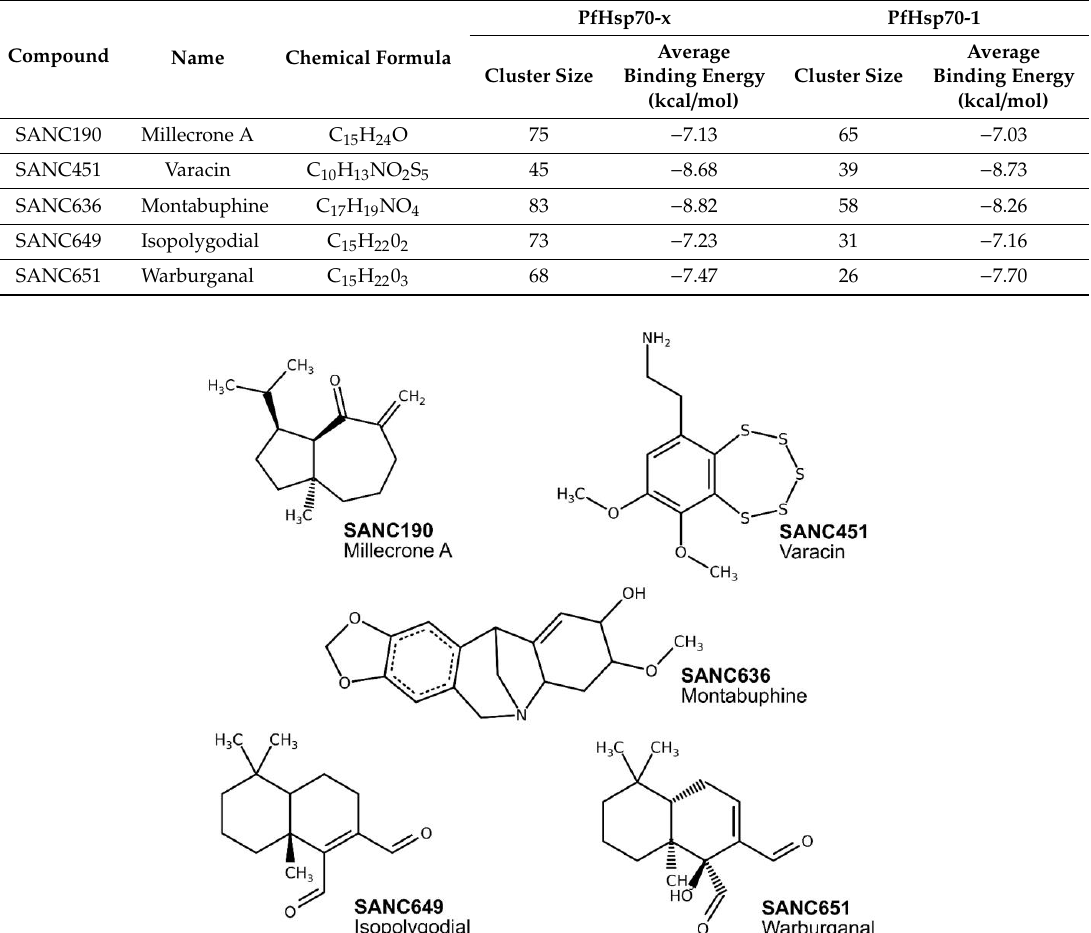
Table 1. Tabulated summary of best ranked docking solutions . All compounds were docked to the